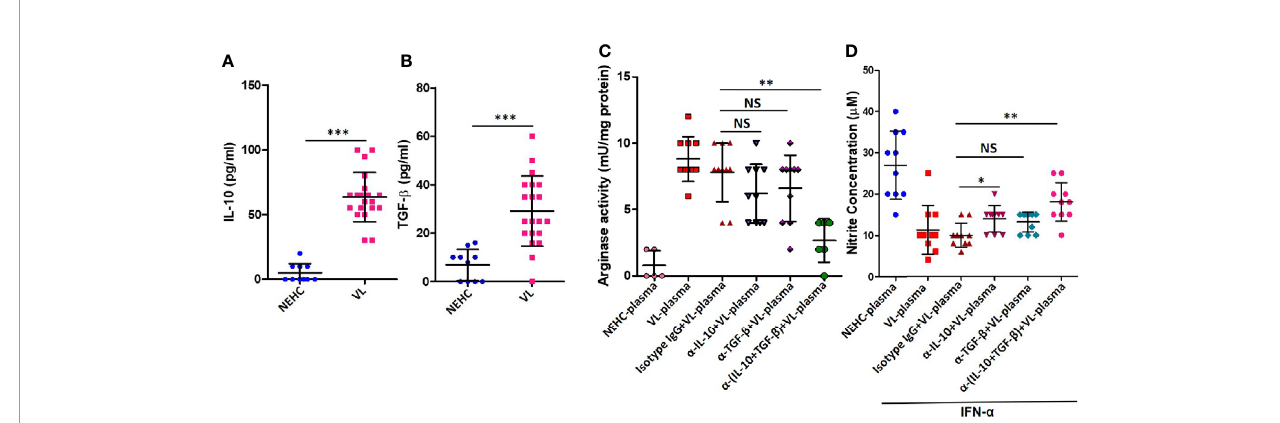
FIGURE 4 | IL-10 and TGF- b in the VL plasma mediate arginase induction in PBMCs. (A) IL-10 cytokine levels were measured in the plasma of NEHCs (n=10) and VL patients (n=20) using an enzyme linked immunosorbent assay. (B) same as in A, but for active TGF- b . (C) PBMCs obtained from NEHCs were incubated with NEHC (n=5) or VL plasma, parental or neutralized either for IL-10 (anti-IL-10 mAb, 10 m g/ml) (n=10) or TGF- b (anti-TGF- b mAb, 10 m g/ml) (n=10) or both IL-10 and TGF- b (n=10) for 24 h and arginase activity in the whole cell lysates was estimated using a protocol detailed in the Methods section. (D) PBMCs conditioned with plasma, same as in (C) , were activated with IFN- a (500 U/ml) for 48 h and nitrite concentration in the cell-free supernatant was measured. Statistical signi fi cance was determined using Mann- Whitney test; *p<0.05, **p<0.01, ***p<0.001; NS, not signi fi cant; PBMC, peripheral blood mononuclear cell; VL, visceral leishmaniasis; NEHC, non-endemic healthy